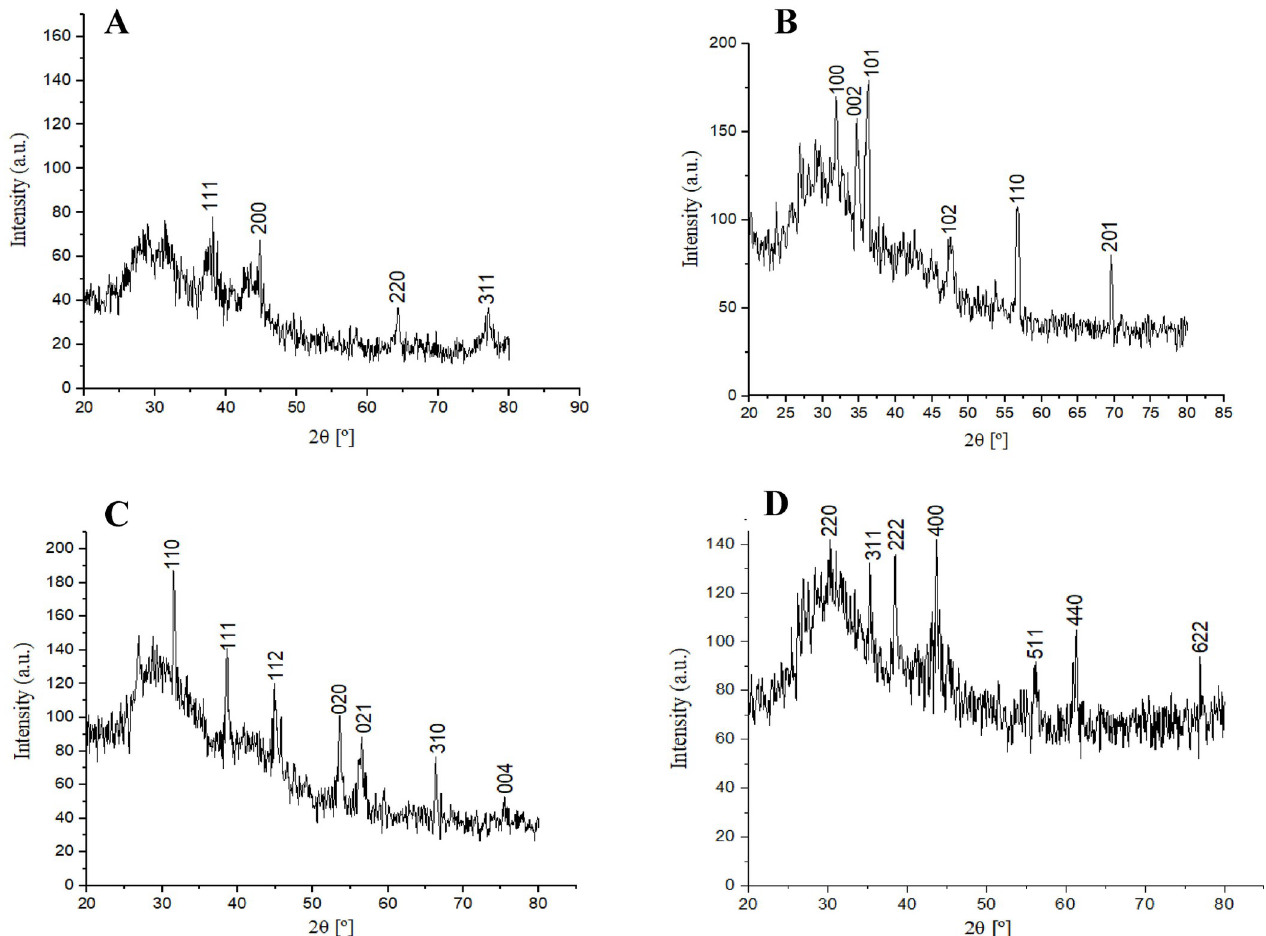
Fig 7. XRD analysis of (A) AgNPs prepared by using 10 mL (2 mM solution) of AgNO 3 with 30 mL of R . communis leaves extract (B) ZnO NPs prepared by using 10 mL (2 mM solution) of ZnSO 4 with 30 mL of R . communis leaves extract (C) CuO NPs prepared by using 10 mL (2 mM solution) of CuSO 4 with 30 mL of R . communis leaves extract (D) FeO NPs prepared by using 10 mL (2 mM solution) of FeCl 3 with 30 mL of R . communis leaves extract.